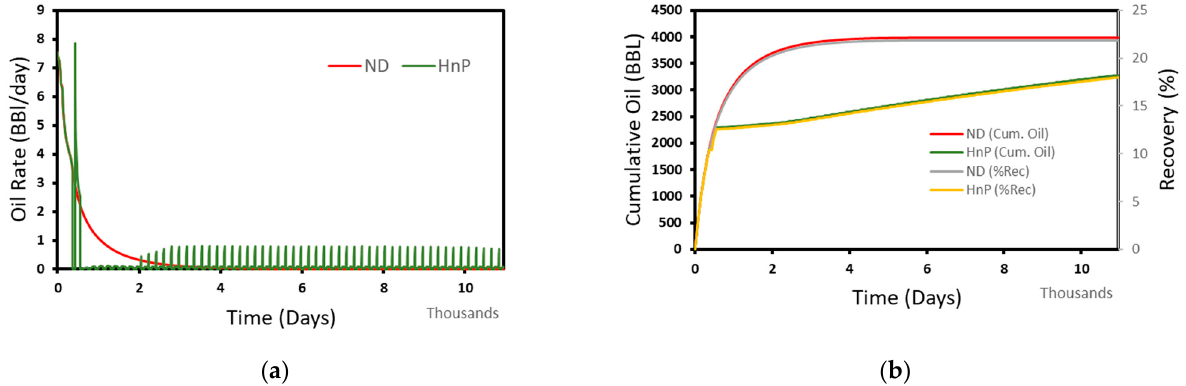
Figure 5. ( a ) Oil rate; ( b ) cumulative oil production and recovery percentage over time. ND: Natural depletion; HnP: huff-n-puff.